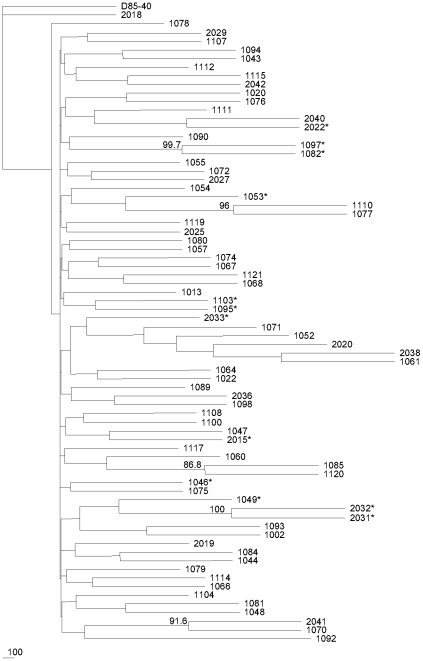
Phylogenetic relationships between analyzed samples.D85_40 at the top is the North-American/European B consensus sequence. * indicates CXCR4-using strains. Bootstrap values above 85% are indicated at the intersections of branches.